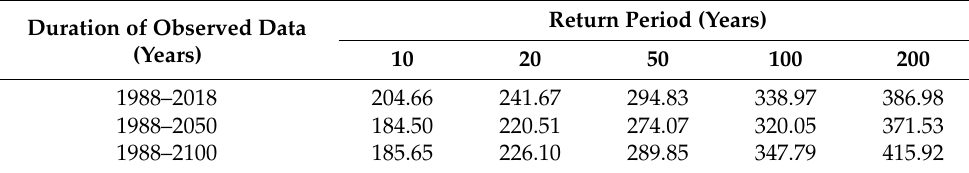
Table 9. Probable annual maximum daily rainfall at Gimhae rainfall station using RCP 8.5 scenario (unit: